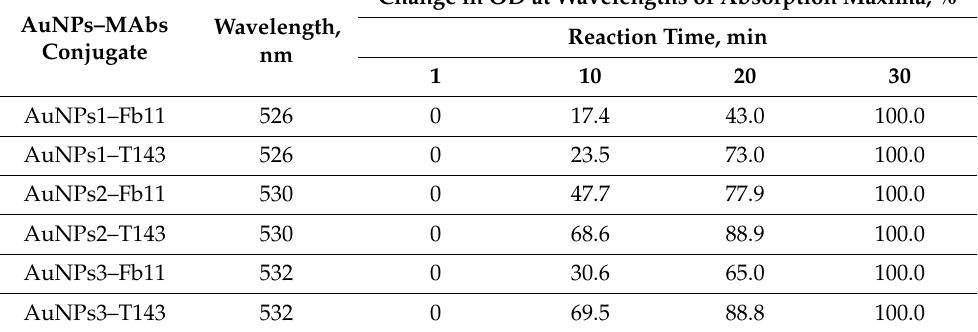
Table 4. Changes in OD over time for the AuNPs–Fb11 (LPS concentration is 10 µ g/mL) and